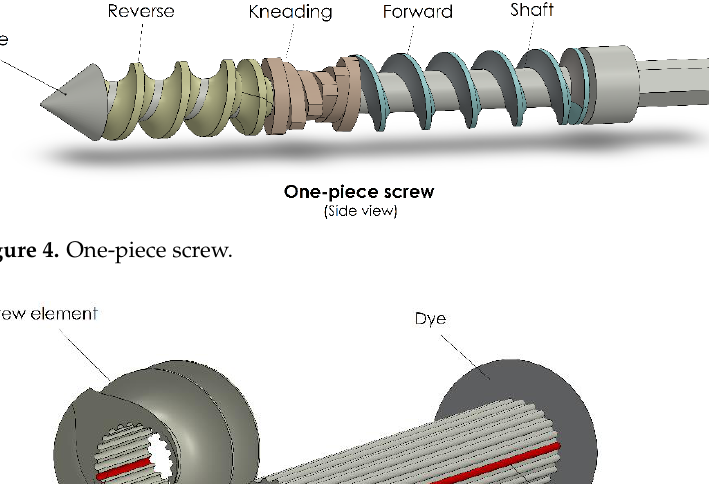
of the screws, which results in the disorganization of the lignocellulose complex, with a